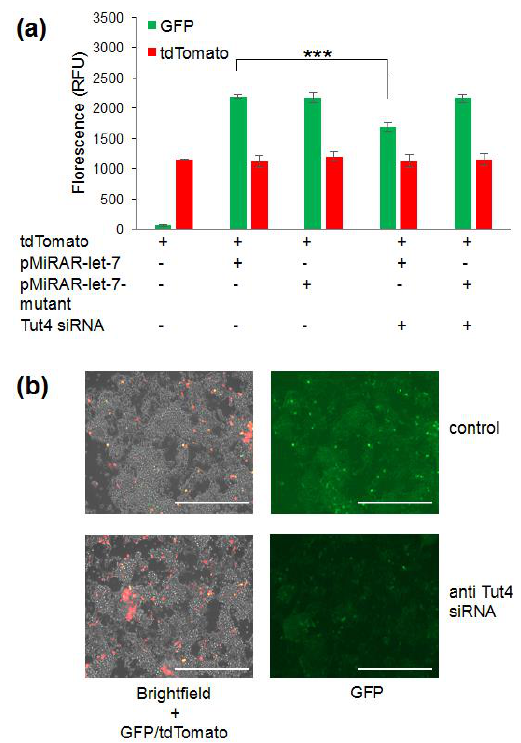
Figure 3. MiRAR – let-7 with KRas-3-UTR is let-7 specific. Fluorescence intensities ( a ) and cell images ( b ) for HEK 293 cells co-transfected with pMiRAR-let-7 and tdTomato. HEK 293 cells were grown to confluence and treated as outlined. Cells were either transfected with the original pMiRAR-let-7 construct (Wild Type (WT)-KRas) or a construct containing mutated let-7 binding sites (pMiRAR-let-7-mutant). Error bars are based on three biological replicates and show one standard deviation. White bars represent 200 µ m. p values are *** <